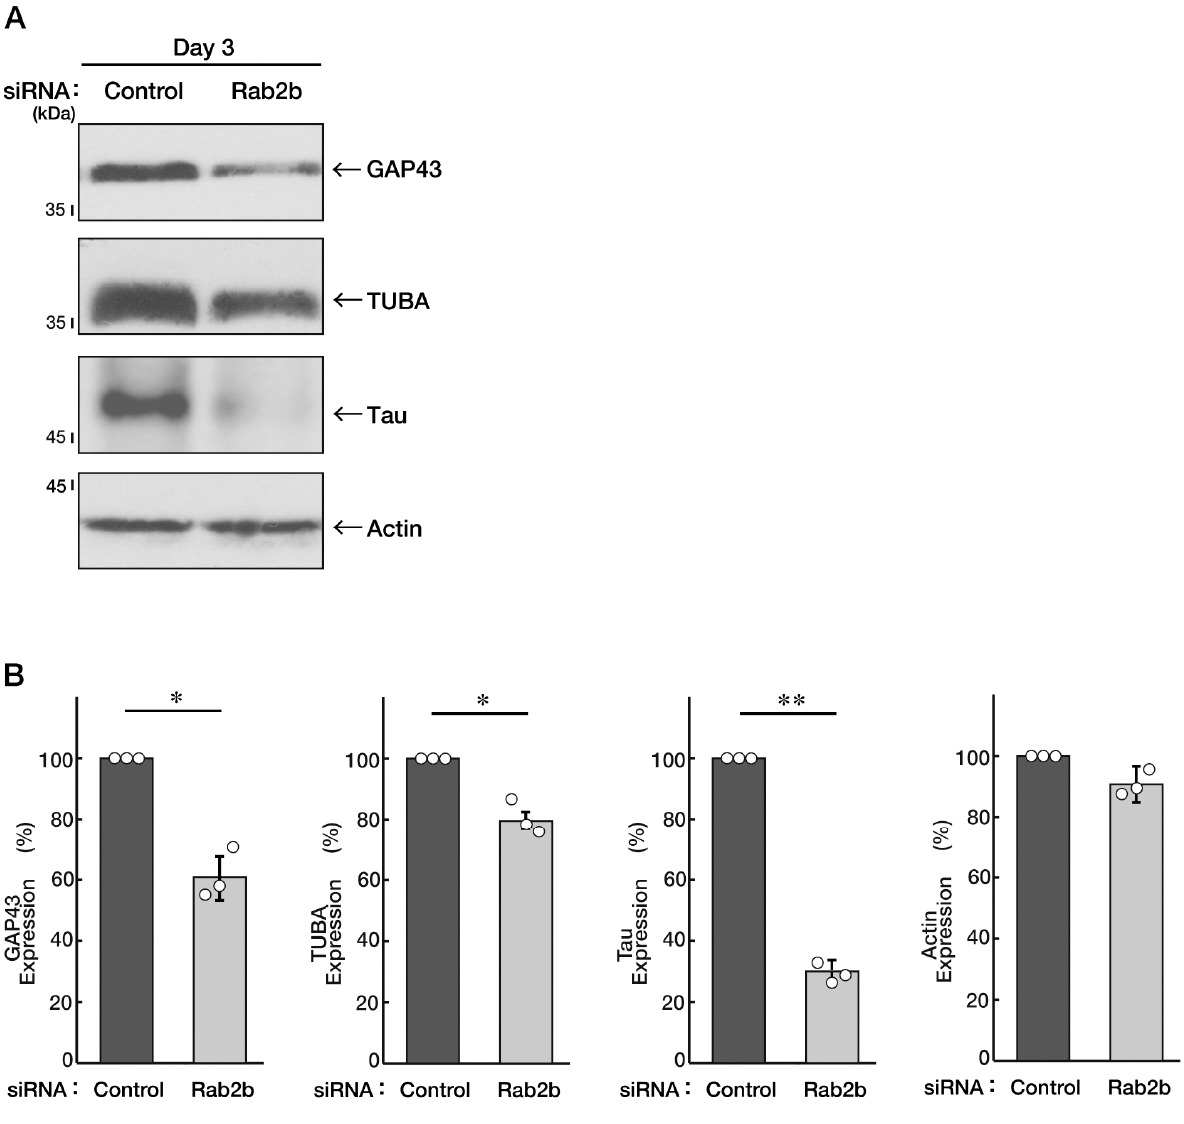
Figure 2. Knockdown of Rab2b decreases expression levels of neuronal differentiation marker proteins. ( A , B ) N1E-115 cells were transfected with a control or Rab2b siRNAs. Transfected cells were allowed to be cultured for 3 days following the induction of differentiation. Each cell lysate was collected for an immunoblotting for an antibody against GAP43, TUBA, Tau, or actin. Immunoreactive bands were quantitatively calculated compared to the respective controls (100%) and statistically depicted as graphs (** p < 0.01, * p < 0.05; n = 3 blots). White circles show percentages in the respective independent experiments.